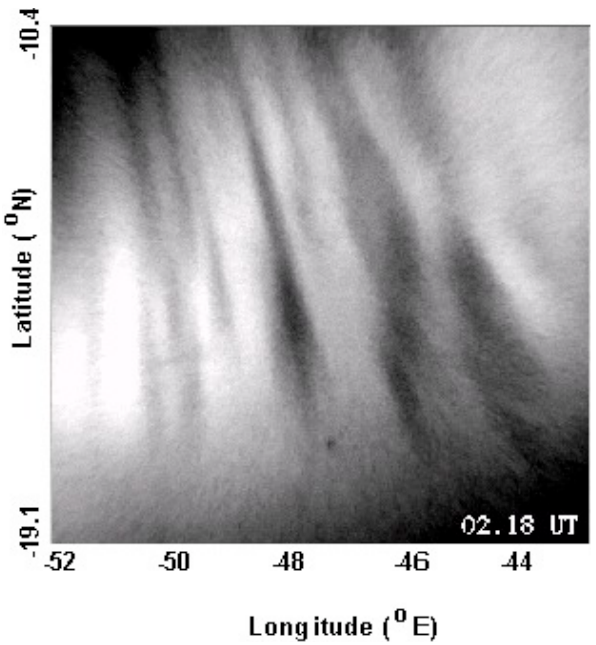
Fig. 6. 6300 ˚A airglow image obtained at Cariri on 2 October 2005. Brightness represents integrated emissions along the line of sight and intensities have been mapped to corresponding latitudes and longitudes assuming a peak emission altitude of 350km. Dark bands indicate depletions in emission intensity within plasma bub- bles, bubbles are aligned along the magnetic field lines, and bubbles are spaced in the normal plane by ∼ 50 to 300km or more.